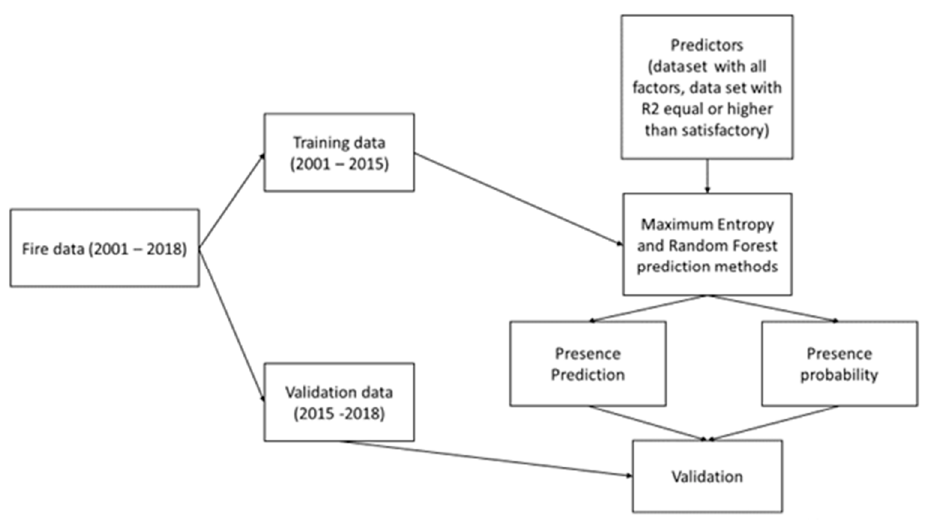
Figure 3. Long-term fire risk modeling methodology.